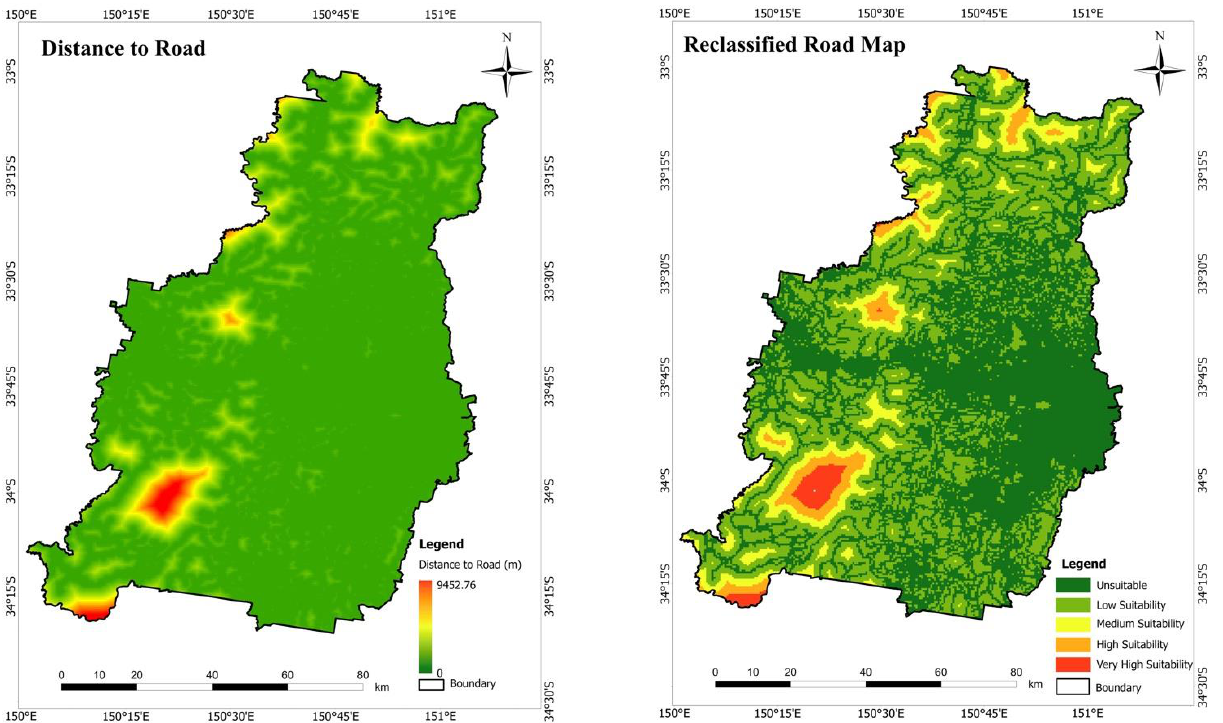
Figure 13. Distance to road map of the study area distance to road ( left ); reclassified distance to road ( right ).